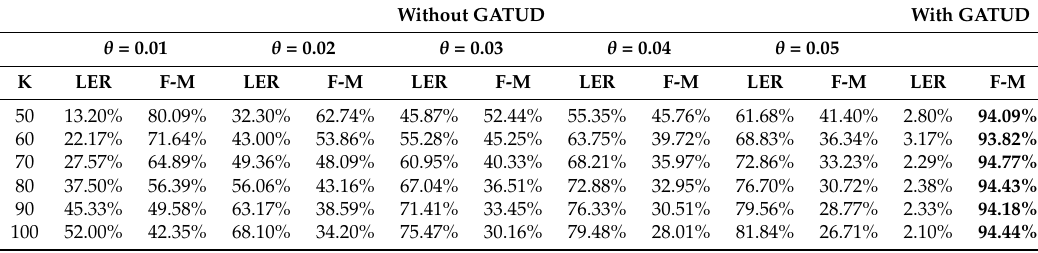
Table 20. The detection accuracy of k -means clustering algorithm with/without GATUD on SIRD. Without GATUD With GATUD θ =